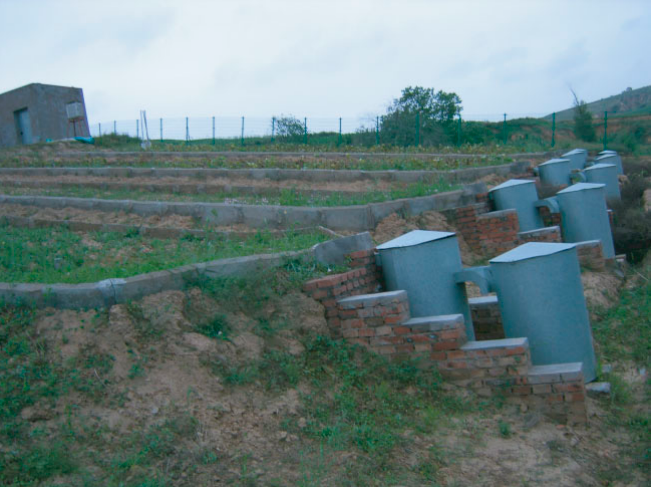
Figure 3. The layout of field plots in XDG watershed.